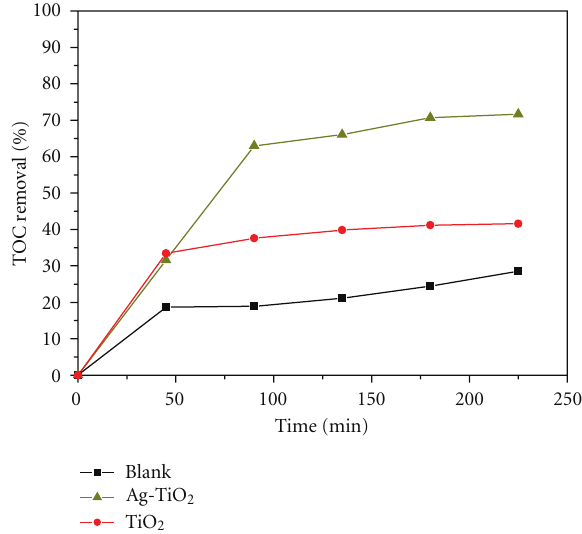
Figure 9: TOC removal percentage of E. coli versus visible light ir- radiation by using TiO 2 and Ag-TiO 2 as photocatalysts.